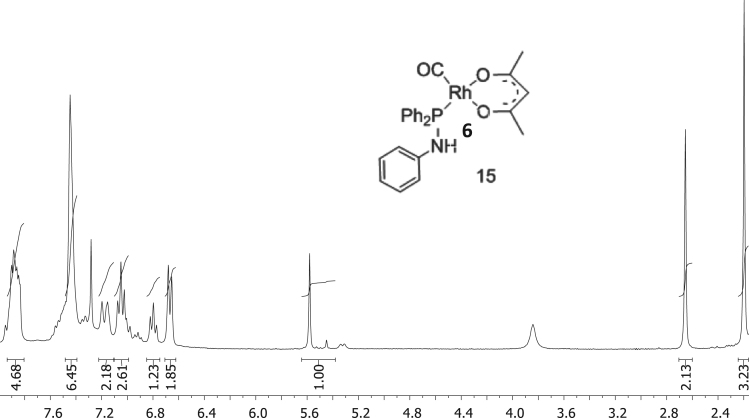
1H NMR of [Rh(acac)CO(C6H4NHPPh2)], 5.